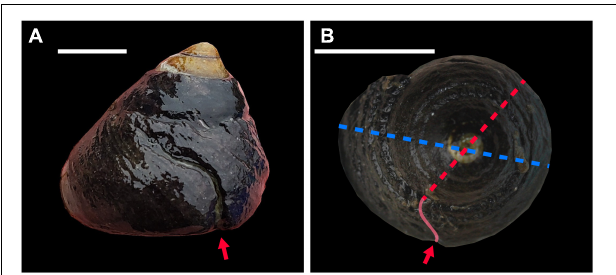
FIGURE 2 | Examples of repair scars on T. funebralis and their measurement. (A) A typical repair scar generated by a failed apertural peel by a crab (red arrow). (B) Size of the gastropod at the time of attack (SAA), measured from where the scar (red arrow, traced by red line) met the top of the whorl where it occurred along a line segment through the center of the gastropod to the opposite edge of the shell (red dotted line). Overall body width measurements were taken as the maximum width (diameter) of the gastropod shell (blue dotted